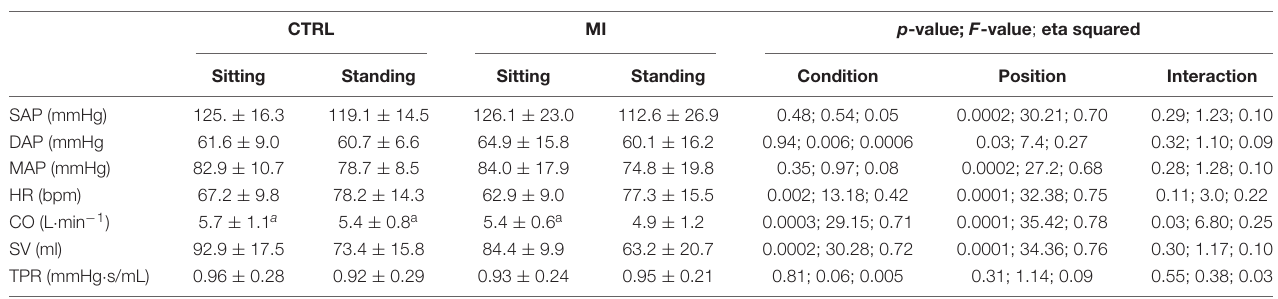
TABLE 3 | Hemodynamic responses during CTRL and MI sessions.